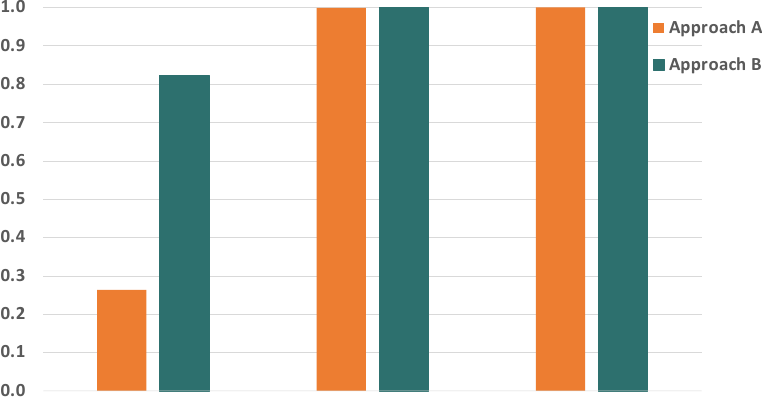
Figure 14. Reliability achievable when varying the number of replicas in a network with a BER of 1 × 10 − 6 . Approach A is represented in orange and approach B in green. The x axis represents the number of replicas, while the y axis represents the